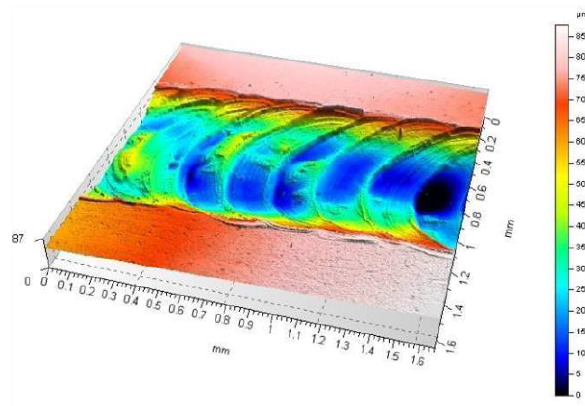
Figure 8: Isometric view of the 0H18N9/0H18N9 weld surface 3D profile tested on the Talysurf CCI Lite optical